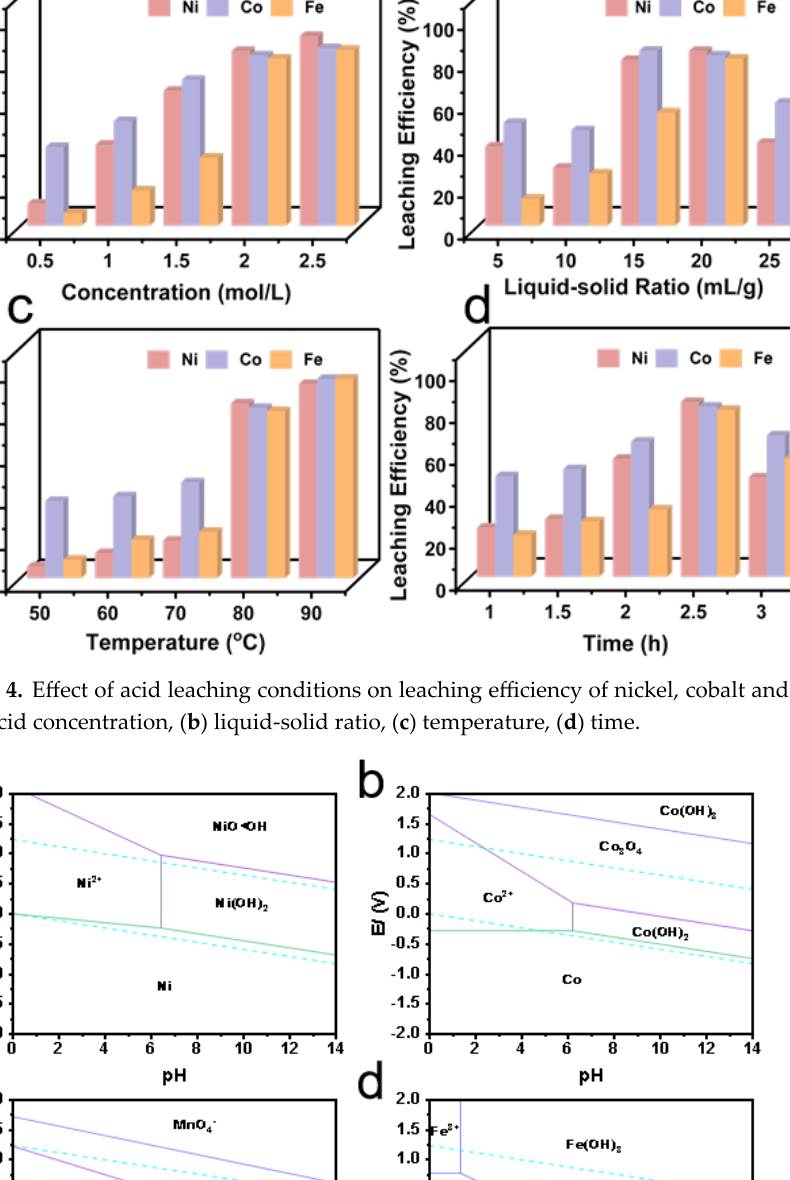
Figure 4. Effect of acid leaching conditions on leaching efficiency of nickel, cobalt and iron. ( a ) sul- furic acid concentration, ( b ) liquid-solid ratio, ( c ) temperature, ( d ) time.